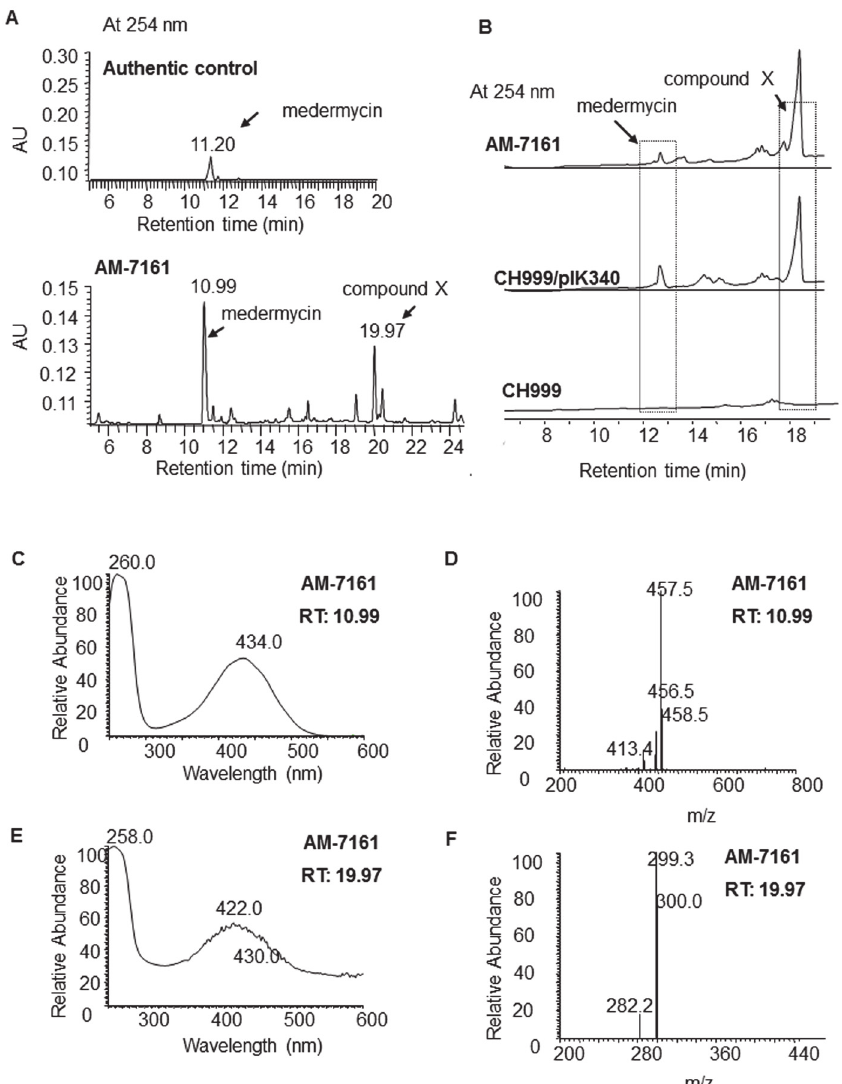
Fig 2. LC/MS analysis of the metabolites by the medermycin-producing Streptomyces sp . AM-7161 and heterologous expression strain. (A) UV absorption at 254 nm of authentic medermycin (upper) and the metabolites by Streptomyces sp . AM-7161 (bottom) (medermycin has a characteristic absorption at 254 nm). (B) UV absorption at 254 nm of metabolites by the wild type strain AM-7161 and heterologous expression strain CH999/pIK340. (C and E) Full-wavelength absorption spectra for two peaks in Fig. 2A at 10.99 min and 19.97 min respectively. (D and F) MS spectra of two peaks in Fig. 2A at 10.99 min and 19.97 min